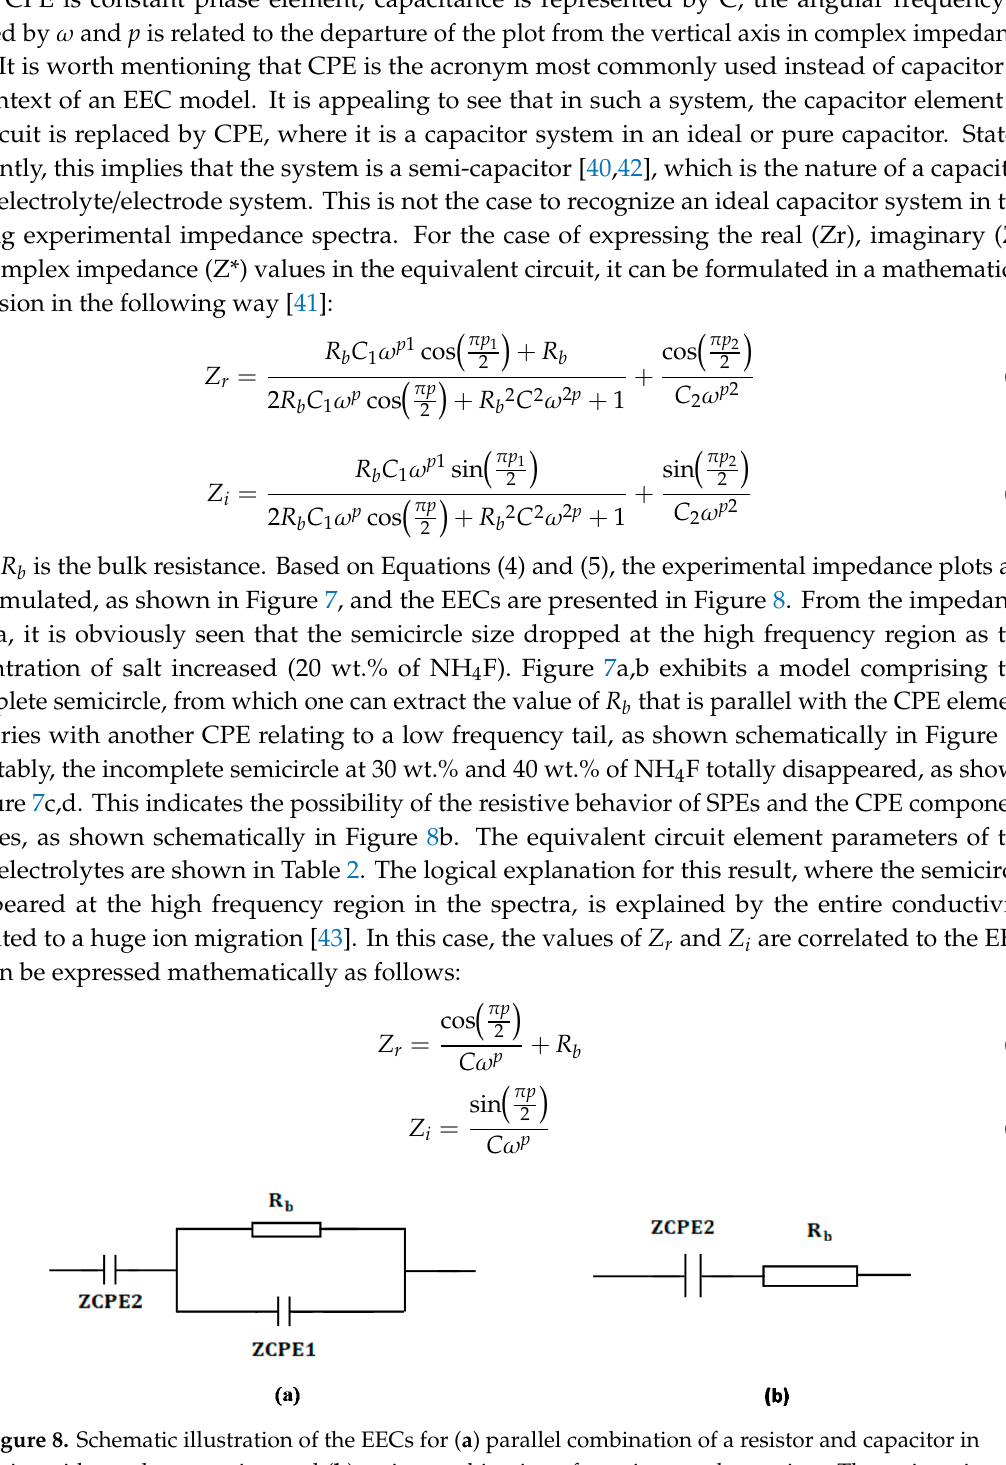
Figure 8. Schematic illustration of the EECs for ( a ) parallel combination of a resistor and capacitor in series with another capacitor and ( b ) series combination of a resistor and capacitor. The resistor is represented by the symbol and the capacitor is represented by .